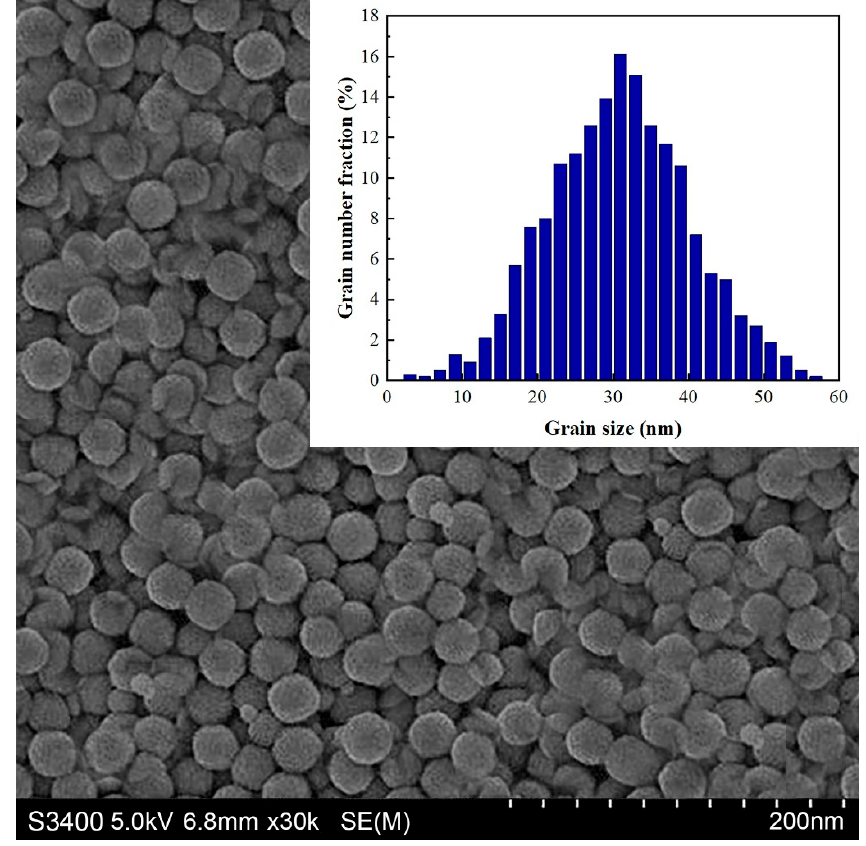
Figure 1. SEM image of SiC nanoparticles. The surface and cross-section microstructures, phase structure, and surface roughness of the Ni/W-SiC nanocomposites were detected by using S3400 type SEM (Hitachi High-Tech. Co., Ltd., Tokyo, Japan), XRD-7000 type XRD (Shimadzu Co., Ltd., Kyoto, Japan), INCA EDX (Oxford Co., Ltd., Oxford, UK), and EPMA-8050 type AFM (Shimadzu Co., Ltd.). In the SEM test, the acceleration voltage was 20 kV, the magnification was 15–200,000, and the resolution ratio was 6 nm. The Ni/W-SiC nanocomposite samples were cut by a DK7740E wire cutting machine (Taizhou Jinggong High-Tech. Co., Ltd., Taizhou, China), and then the cross-section images of the samples could be observed. In the AFM experiment, the scanning pattern was tapping mode, the probe was silicon nitride, and the lateral resolution was 0.2 nm. In the XRD measurement, a Cu target was utilized with a tube voltage of 30 kV, and the scanning step was 0.01 ◦ . The X-ray wavelength was 0.15406 nm, and the diffraction angle was set at 20 ◦ ~90 ◦ . The Ni/W grain diameter ( D ) was estimated using the Equation (1) as follows: